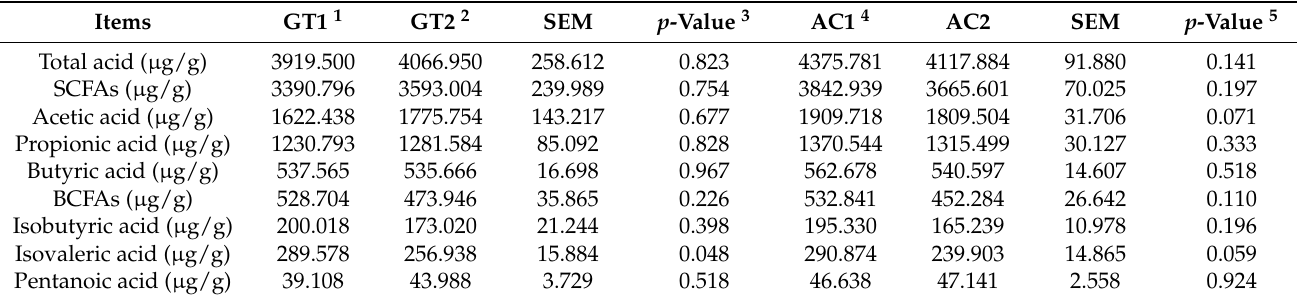
Table 4. Fecal SCFA and BCFA contents between different groups.